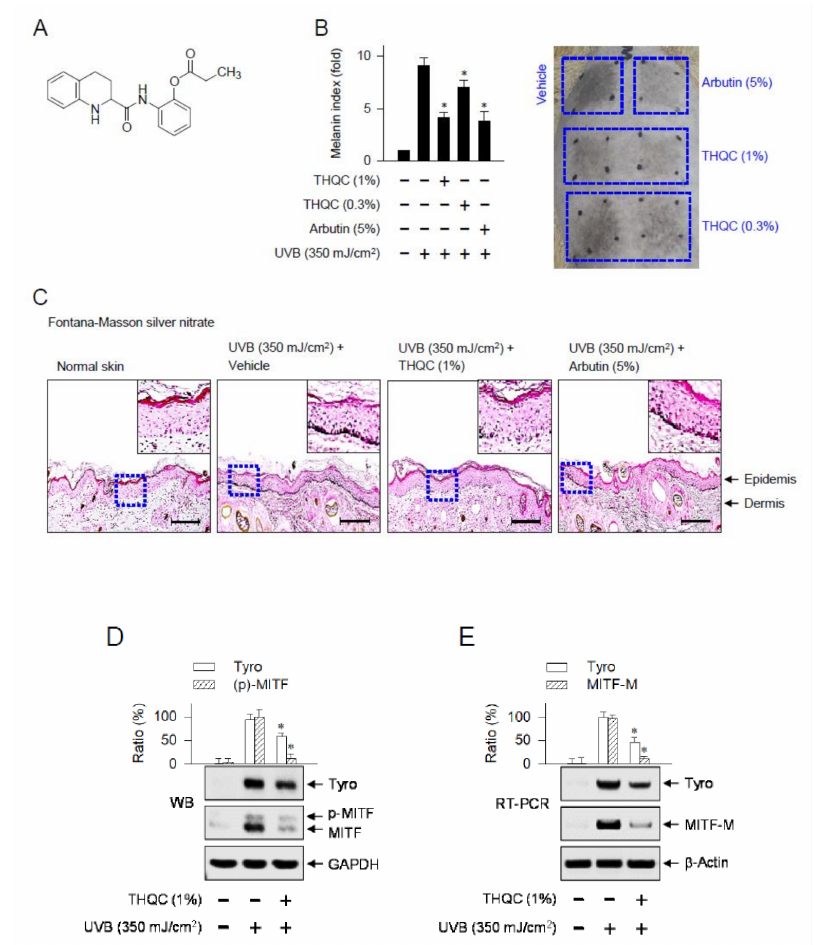
Figure 1. E ff ect of tetrahydroquinoline carboxamide (THQC) on skin pigmentation in guinea pig. ( A ) Chemical structure of THQC. ( B – E ) Dorsal skin of guinea pig was irradiated with ultraviolet B (UVB) and treated topically with THQC according to the protocol in Figure S1 (Supplementary Materials). ( B ) The melanin index was measured in UVB-exposed area of skin and is represented as relative fold. A photograph of pigmented skin is also presented. The vehicle was a mixture of propylene